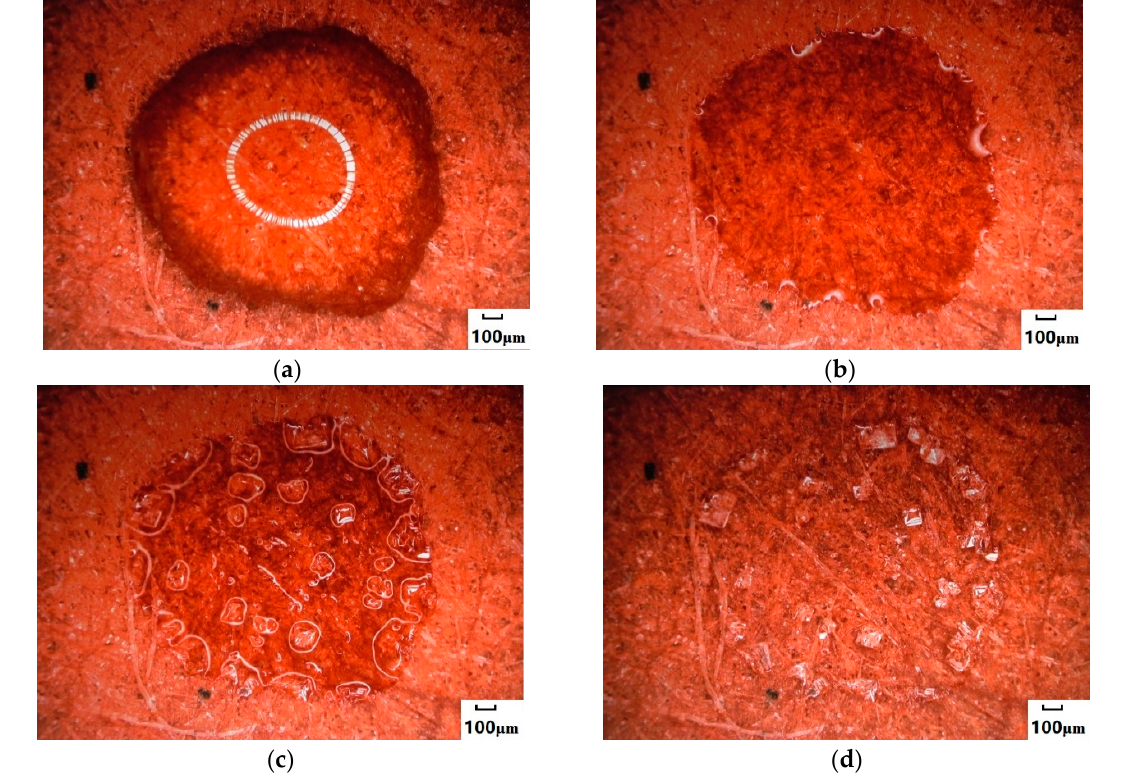
Figure 2. Crystallization process of NaCl droplets on the surface of hydrophilic media. ( a ) Droplets. The dark part is the edge of the droplet, and the white circle is the reflected light at the top of the circular droplet. ( b ) The edge of droplets began to crystallize. ( c ) Crystals grew. ( d ) Crystals were desiccated.